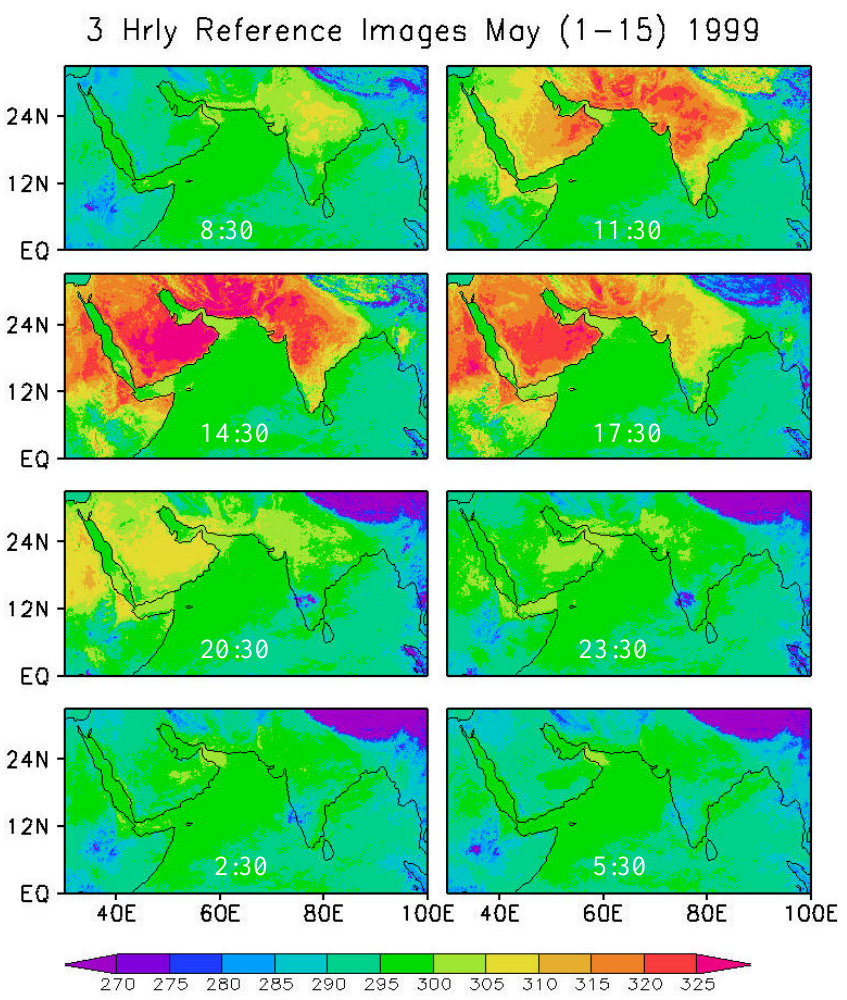
Table-5. SW Dust Radiative Forcing at Top of the Atmosphere for 1999 IDDI (K) SW Dust Radiative Forcing (W m -2 ) MeanLocation July Dec. Ann. July Dec.